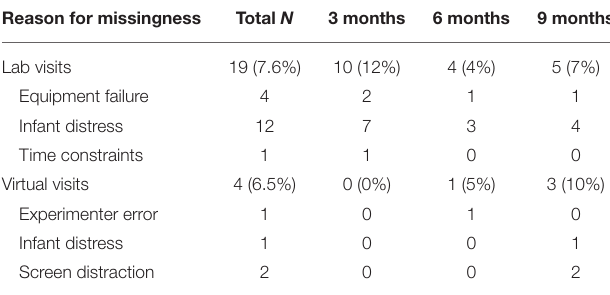
TABLE 3 | Dyads with data missing for the Still Face Paradigm as a function of visit type.